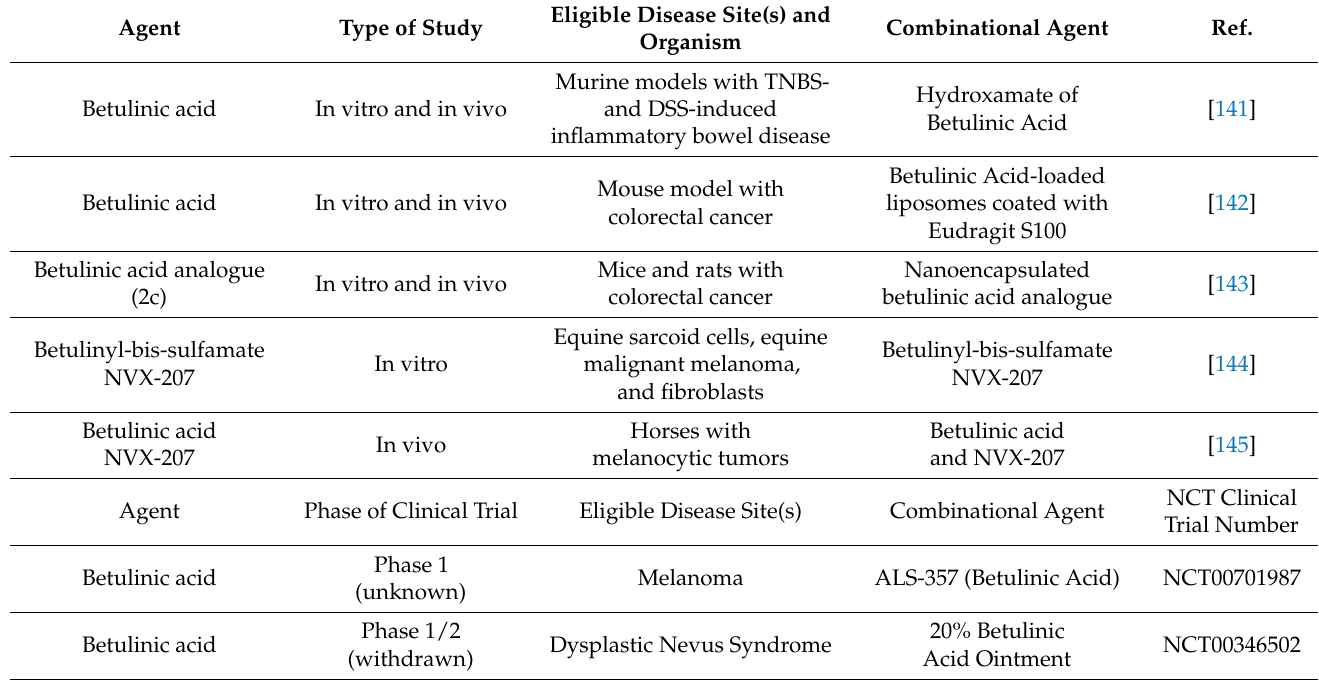
Table 3. Preclinical and clinical studies with betulinic acid and its